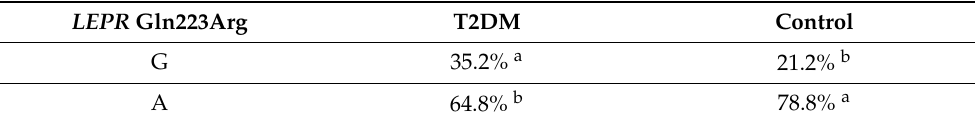
Table 2. Frequency of LEPR Gln223Arg alleles in T2DM and control groups. LEPR Gln223Arg T2DM Control G 35.2% a 21.2% b A 64.8% b 78.8% a